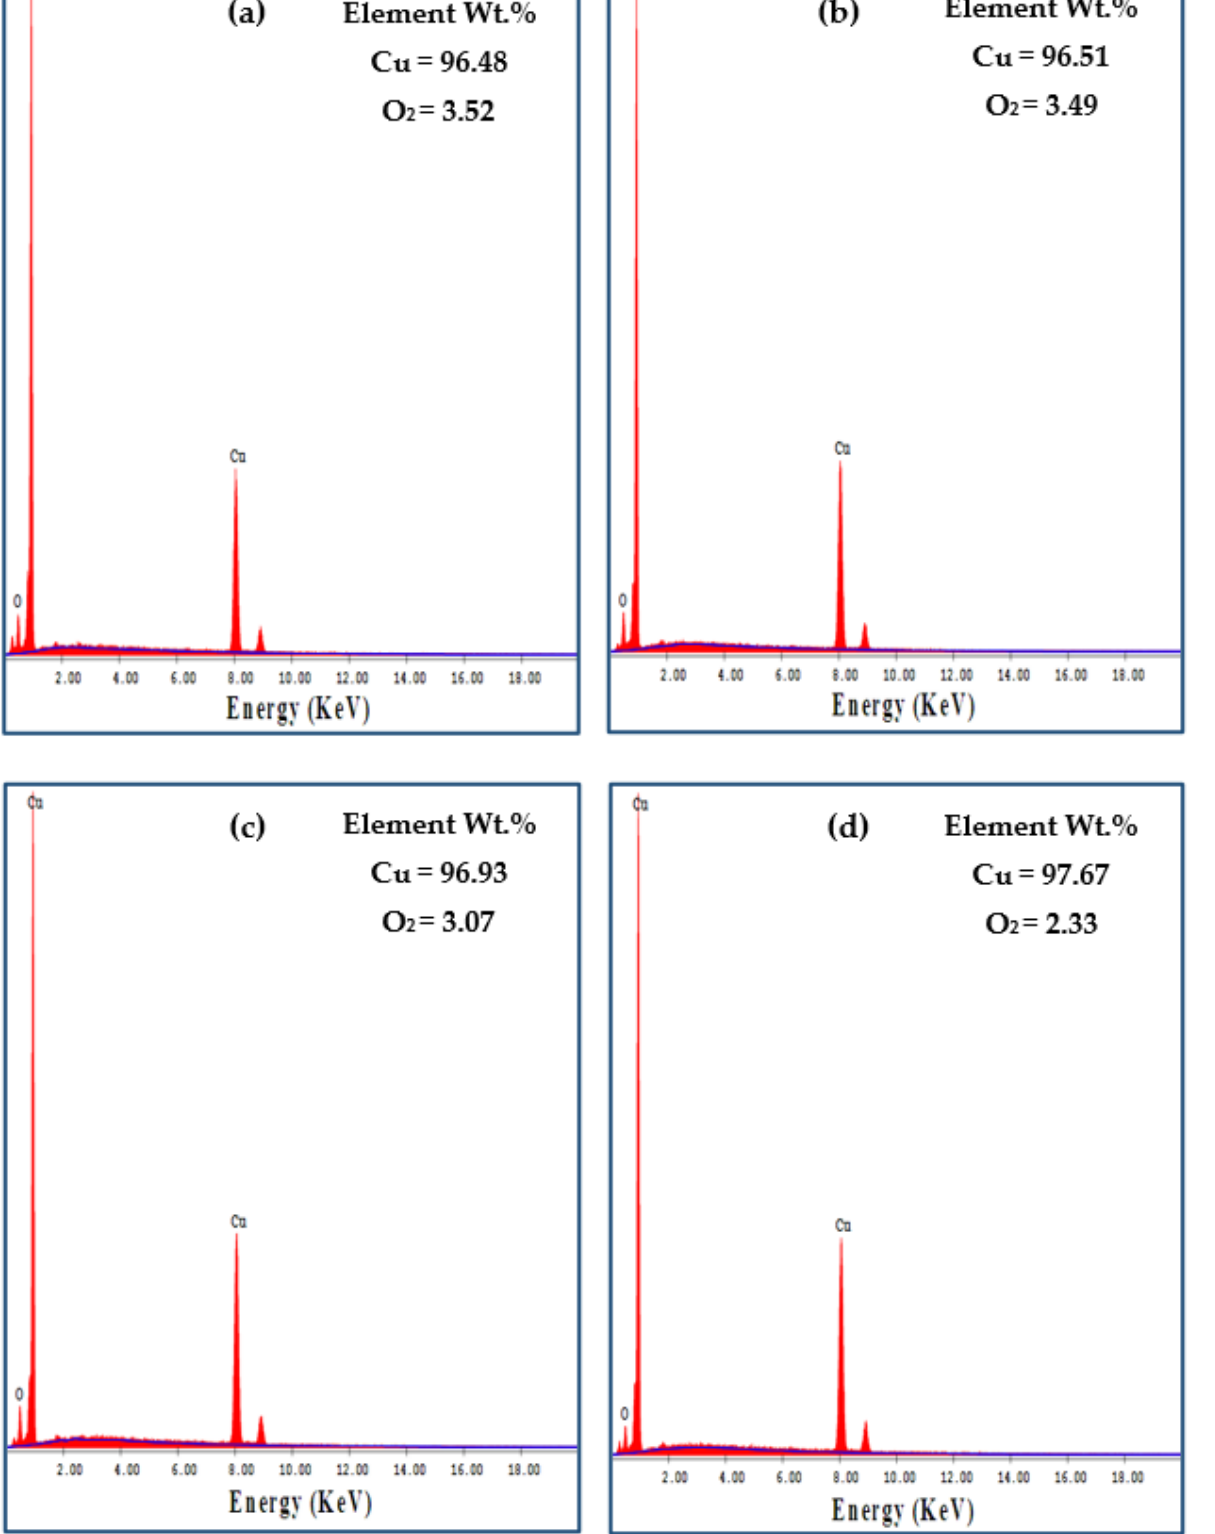
Figure 12. EDS analysis of the worn surface of ( a ) annealed, ( b ) 1 pass, ( c ) 2 passes, and ( d ) 4 passes of Cu tubes under a sliding distance of 1375.2 m and an applied load of 50 N.